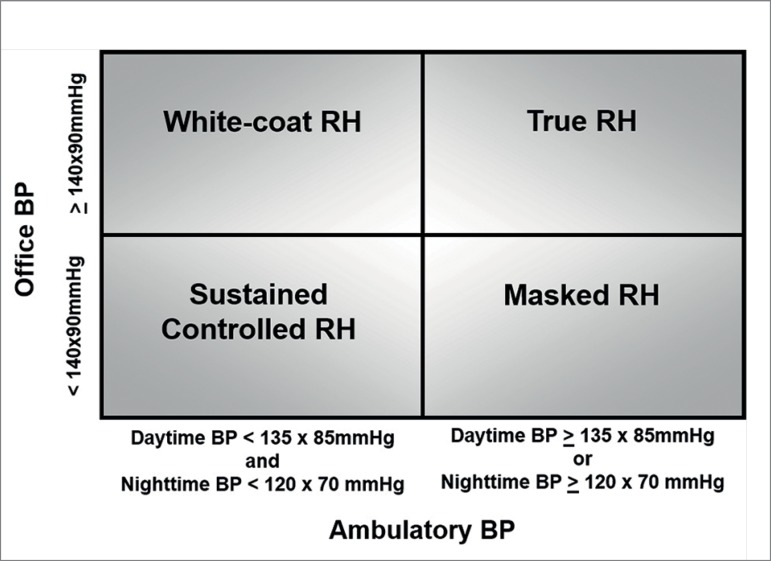
Classification of resistant hypertension into four subgroups
according to office and ambulatory blood pressure measurements:
controlled, masked, white-coat, and true resistant hypertension
(authorized reproduction from Muxfeldt et al28)